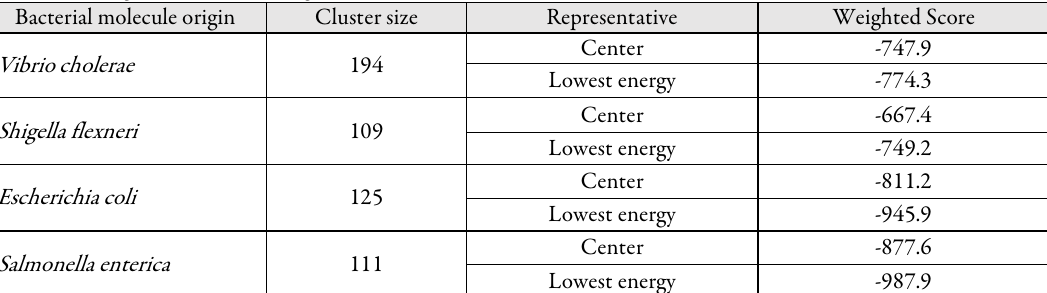
Table 3. Model scores for the docking coagulation factor VII to bacteria species. with the energy of the cluster center (i.e., the structure that has the highest number of neighbours structures in the cluster), and